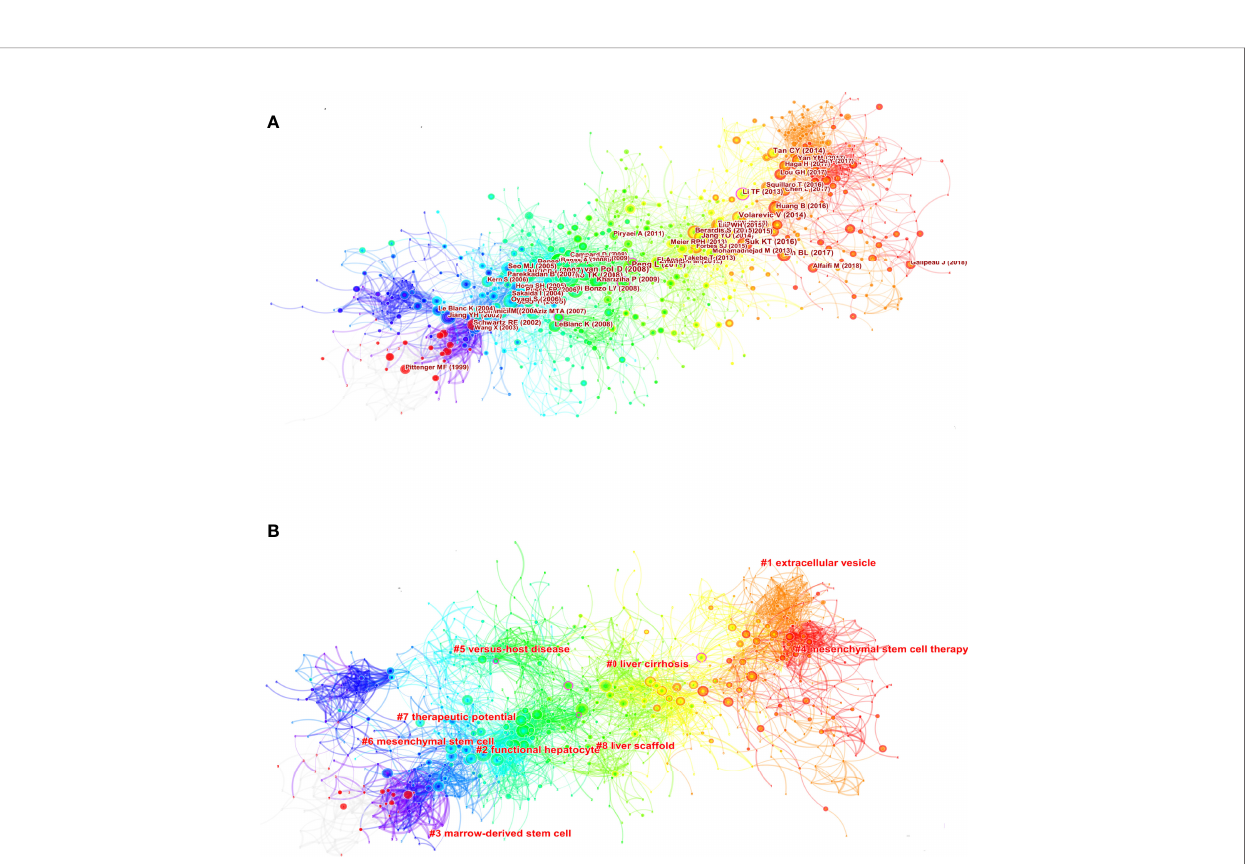
FIGURE 6 | The dual-map overlay of journals. The citing journals were on the left, the cited journals were on the right, and the colored path represents the citation